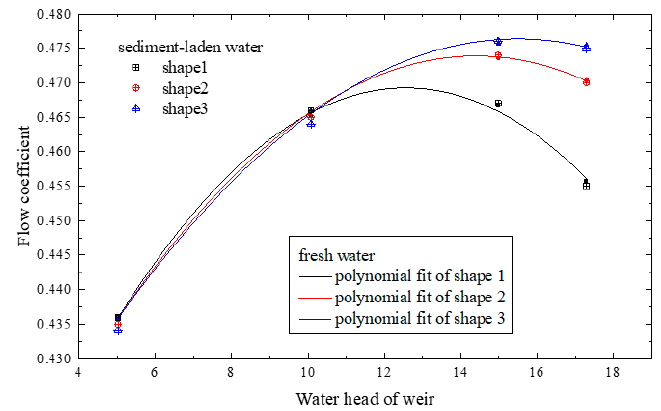
Figure 4. Relationship between the upstream water head and the flow coefficient with different contraction ratios for fresh water and sediment-laden flow with concentrations of 150 kg/m 3 .